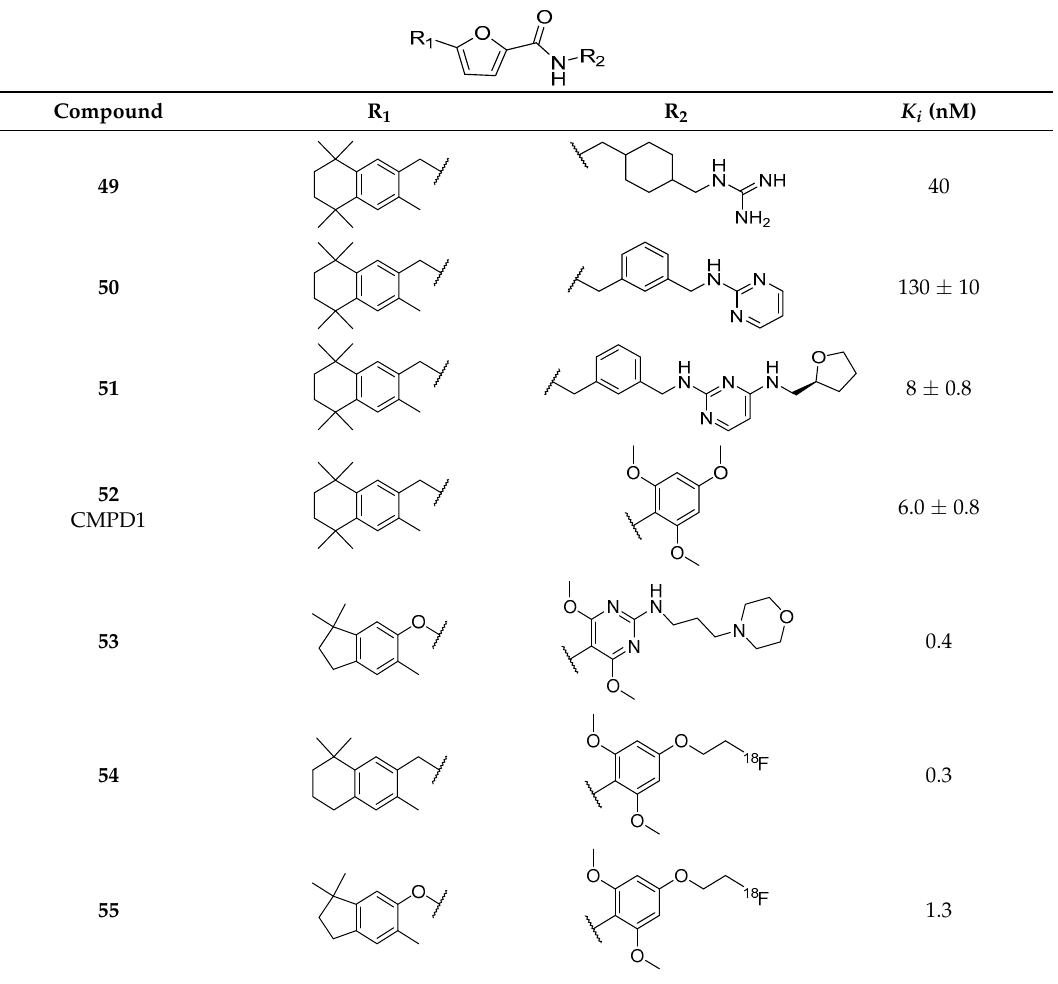
Table 9. Furamide derivatives and their binding affinity at human GnRH-R.